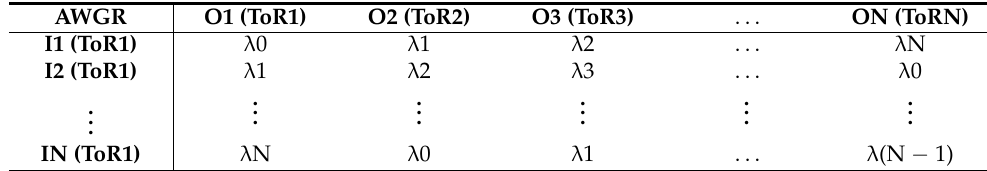
Figure 1. A schematic diagram of the OW-DCN architecture; FSO: free-space optical; IAS: intra-cluster AWGR-based switch; EAS: inter-cluster AWGR-based switch; ToR: top of rack. Table 1. The wavelength mapping of a N × N-port